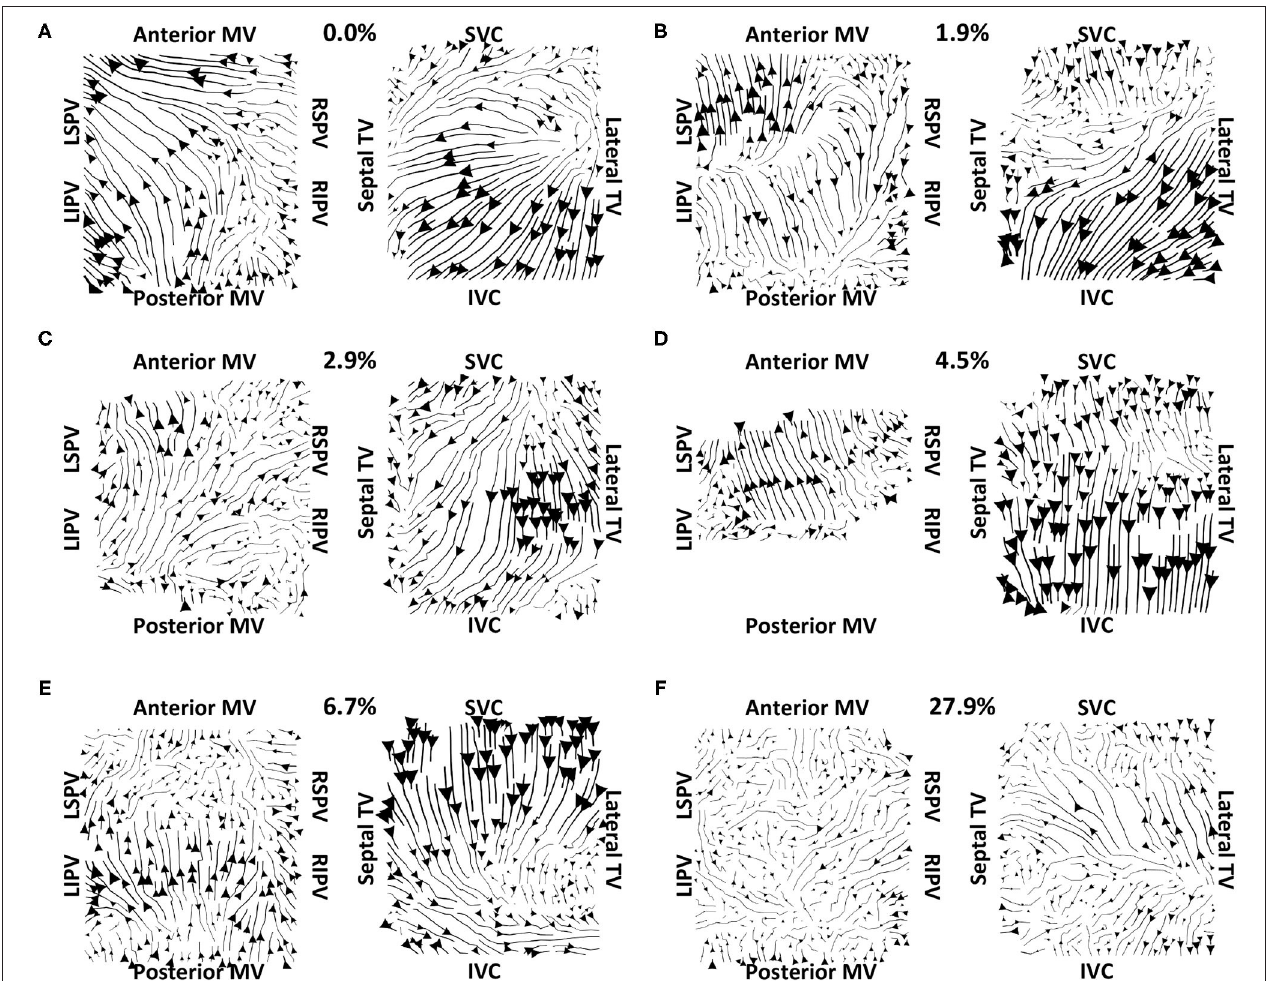
FIGURE 7 | Clinical average vector fields did not demonstrate activation flow from the PV antra into the atrial body for PVI non-responder cases pre-ablation. Visualisation details are as in Figure 6 . Cases are arranged in order of increasing PV activation flow metric: (A) 0, (B) 1.9, (C) 2.9, (D) 4.5, (E) 6.7, and (F) 27.9%. For case (D) , multiple splines of the LA basket were not in contact and so these were excluded from the analysis.